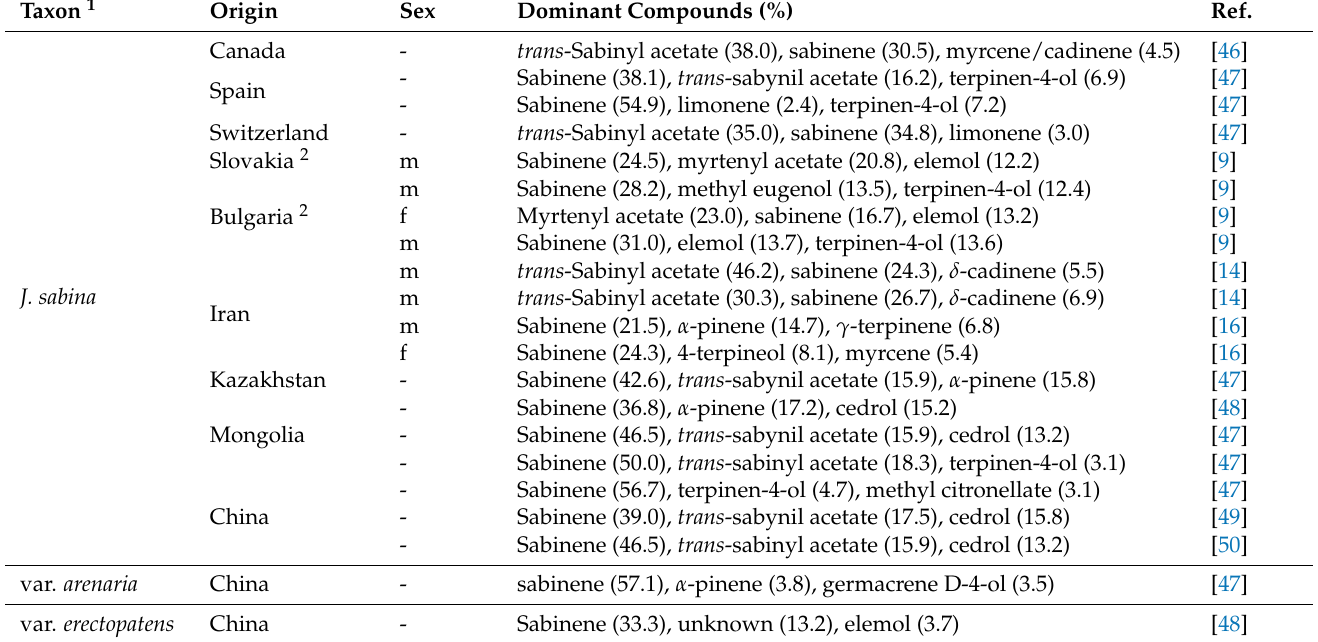
Table 6. Three dominant compounds in Juniperus sabina leaf essential oil composition from the